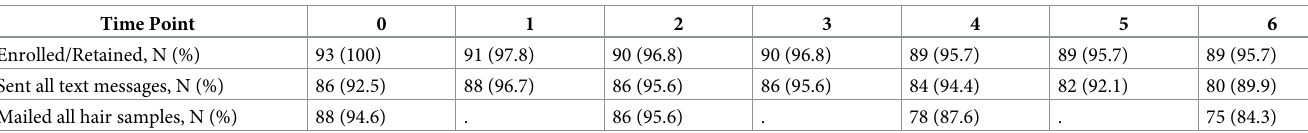
Table 2. Feasibility of participant enrollment, engagement, and